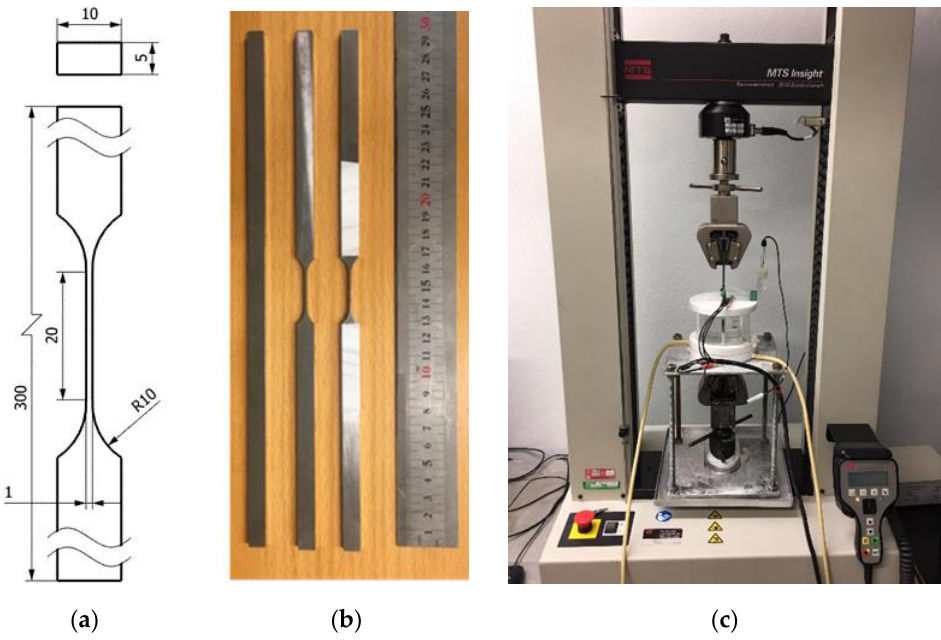
Figure 2. ( a ) Dimensions of mechanical testing (MT) specimens; ( b ) MT specimens prior to H-charging; ( c ) assembly of MT specimen with the electrochemical cell and loading unit for tensile testing (CERTs and CLTs) under continuous H-charging.